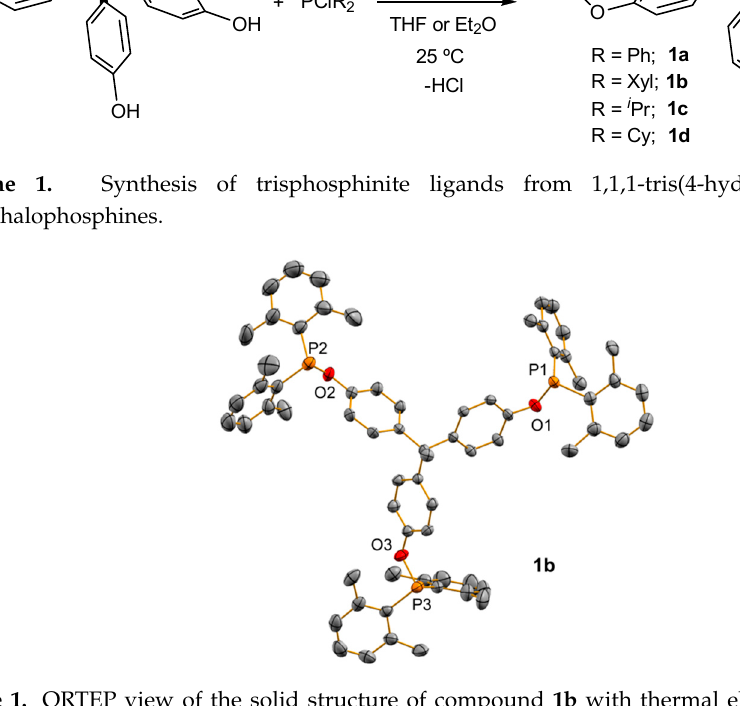
Figure 1. ORTEP view of the solid structure of compound 1b with thermal ellipsoids set at 50% probability. Hydrogen atoms have been excluded for the sake of clarity.